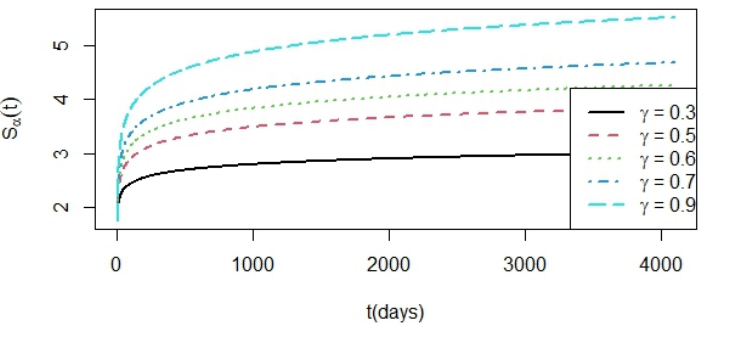
Figure 9. The entropy analysis for fitting the real data market USD/SAR exchange rate, where α = 1.99 for all γ values in the interval ( 0,1 ) ; when α is close to 2, it indicates that the exchange rate of USD/SAR has a normal